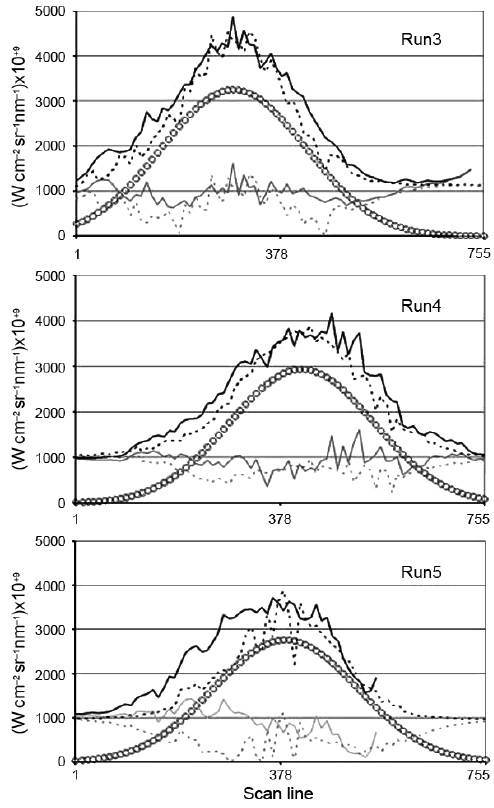
Fig. 7. For each flight run two radiance profiles taken at 560 nm (the corresponding scan lines are traced in red and yellow in fig. 5) are displayed. Val- ues before (black lines) and after correction (gray line) are compared. The applied slope probability density function is drown with a